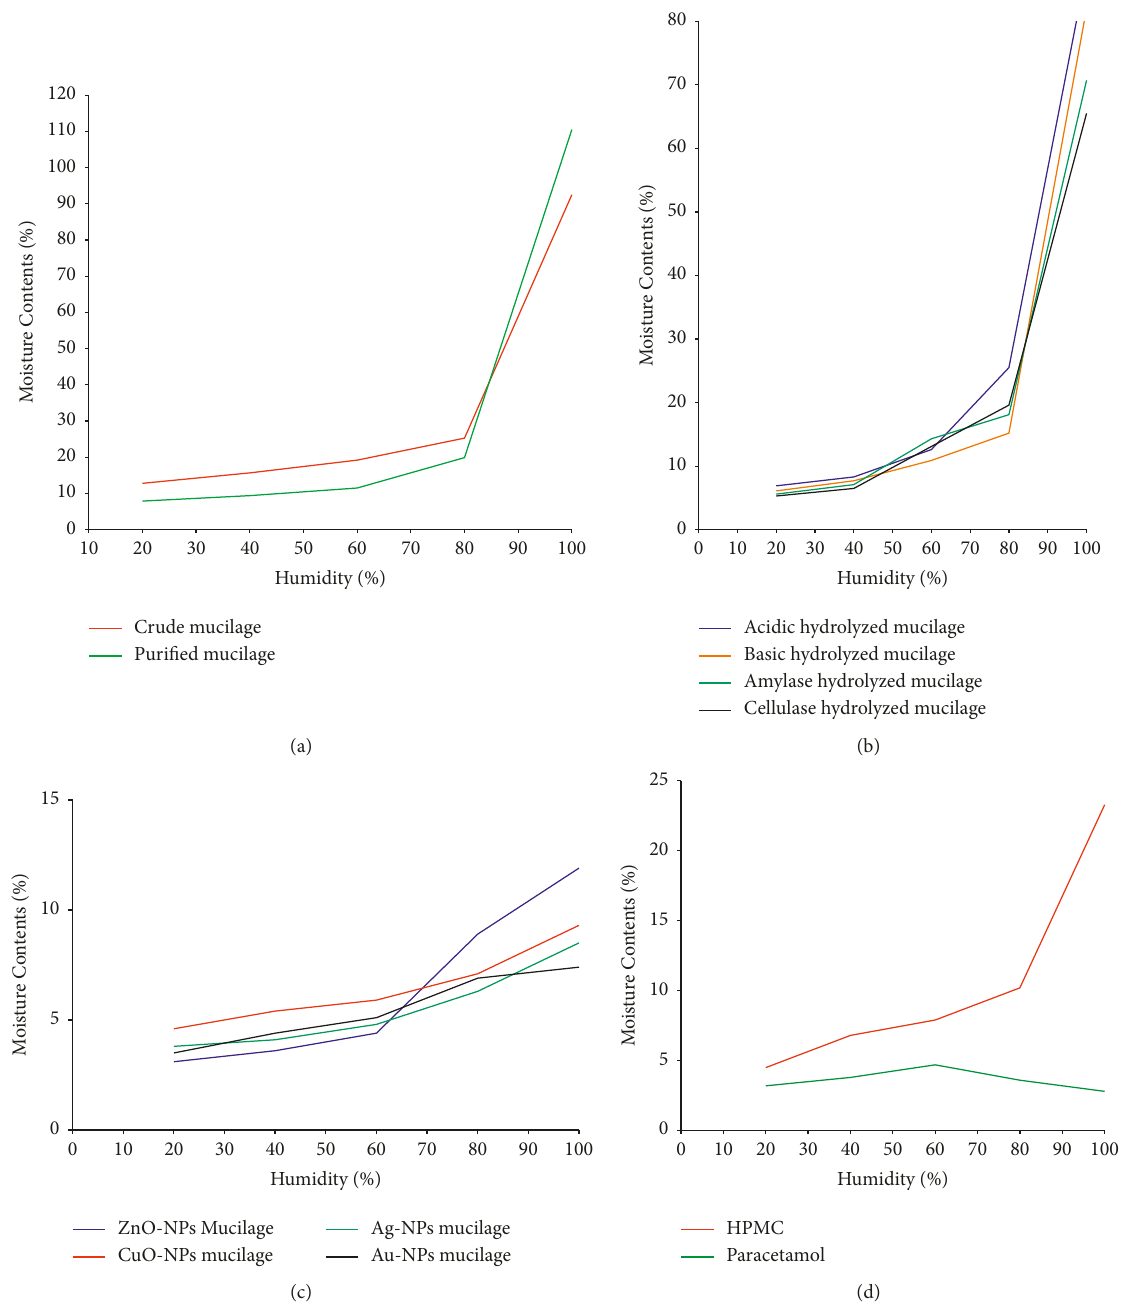
Figure 2: Moisture sorption profile of crude, purified, and modified date palm mucilage, green synthesized nanoparticles, HPMC, and paracetamol. (a) Moisture sorption profile of crude and purified date palm mucilage; (b) moisture sorption profile of modified date palm mucilage; (c) moisture sorption profile of green synthesized nanoparticles of date palm mucilage; (d) moisture sorption profile of HPMC and